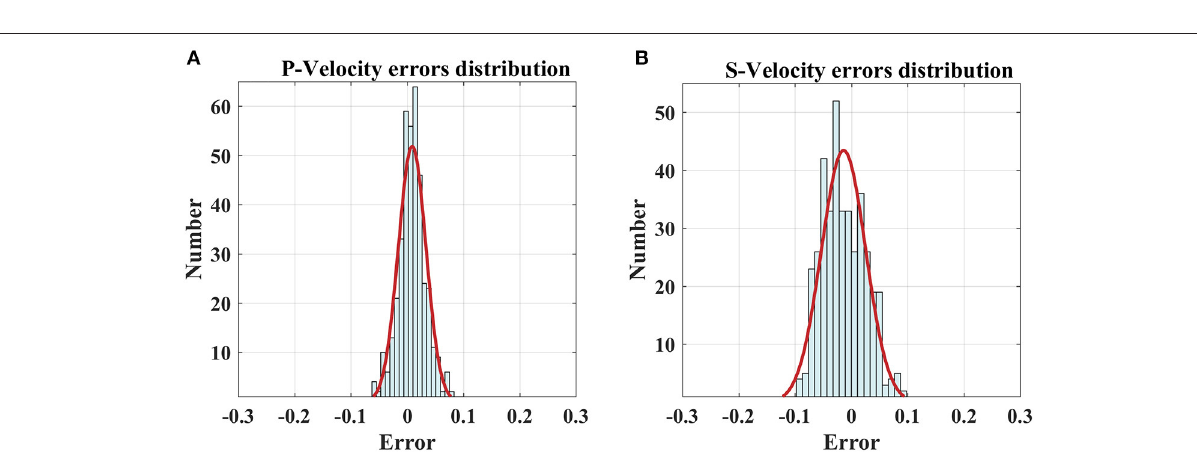
FIGURE 5 | Errors between the estimated P-wave/S-wave velocity and measured values. (A) The errors distribution of P-wave velocity, (B) the errors distribution of S-wave